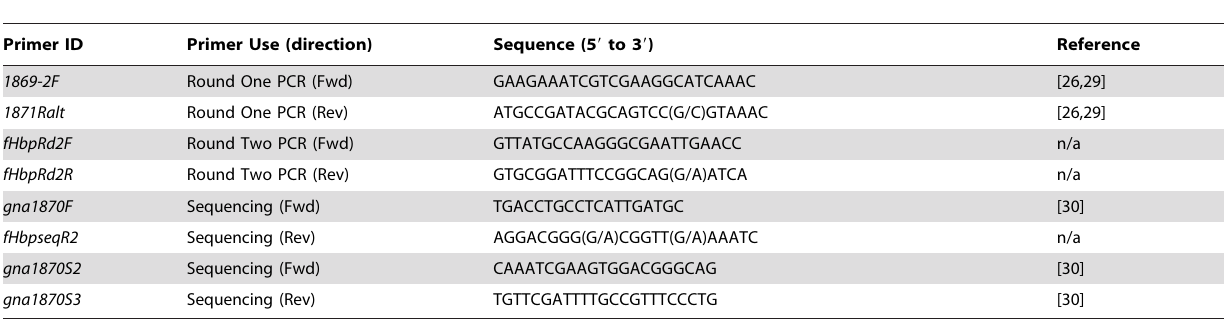
Table 2. PCR and sequencing